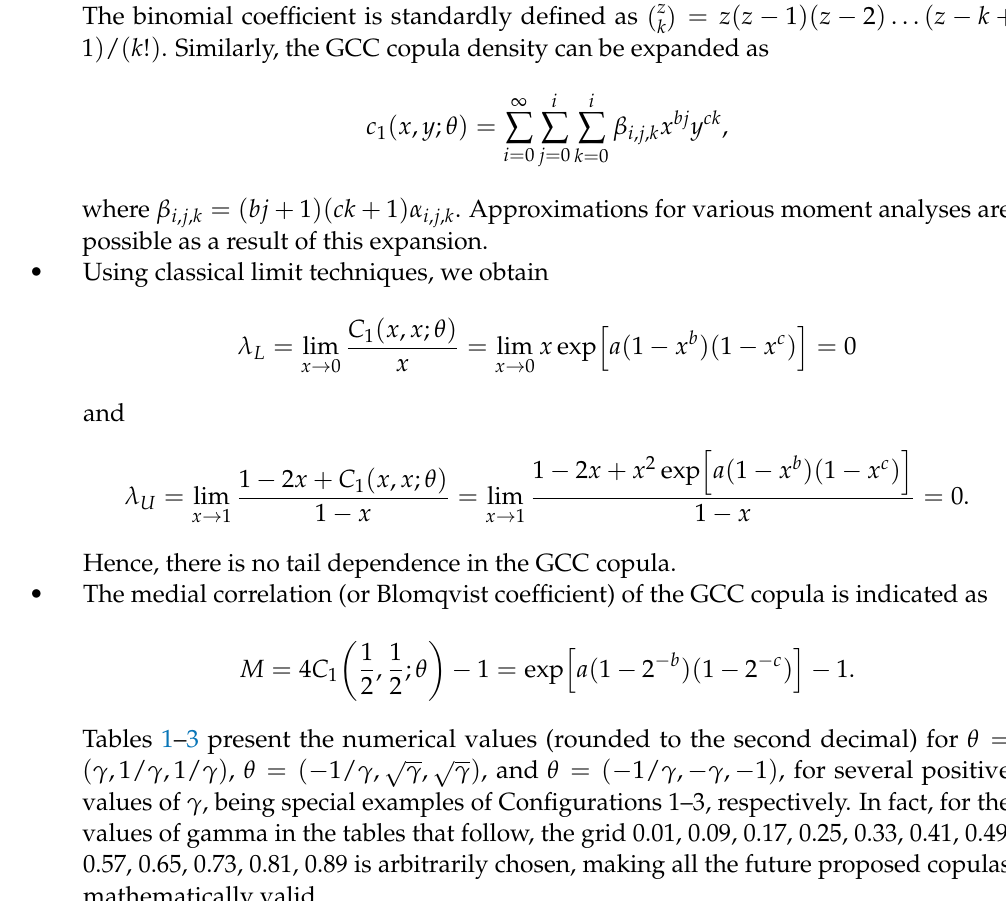
Table 1. Values of the medial correlation of the GCC copula for θ = ( γ ,1/ γ ,1/ γ ) and several values of γ , belonging to Configuration 1.